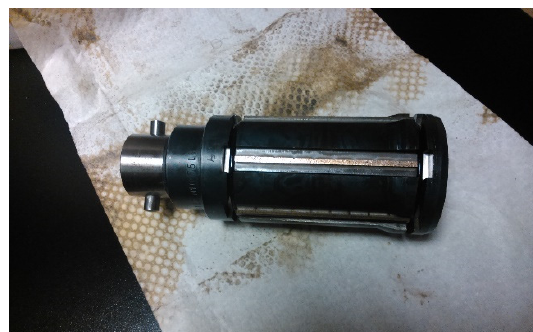
Figure 2. Honing head used in the experiment.